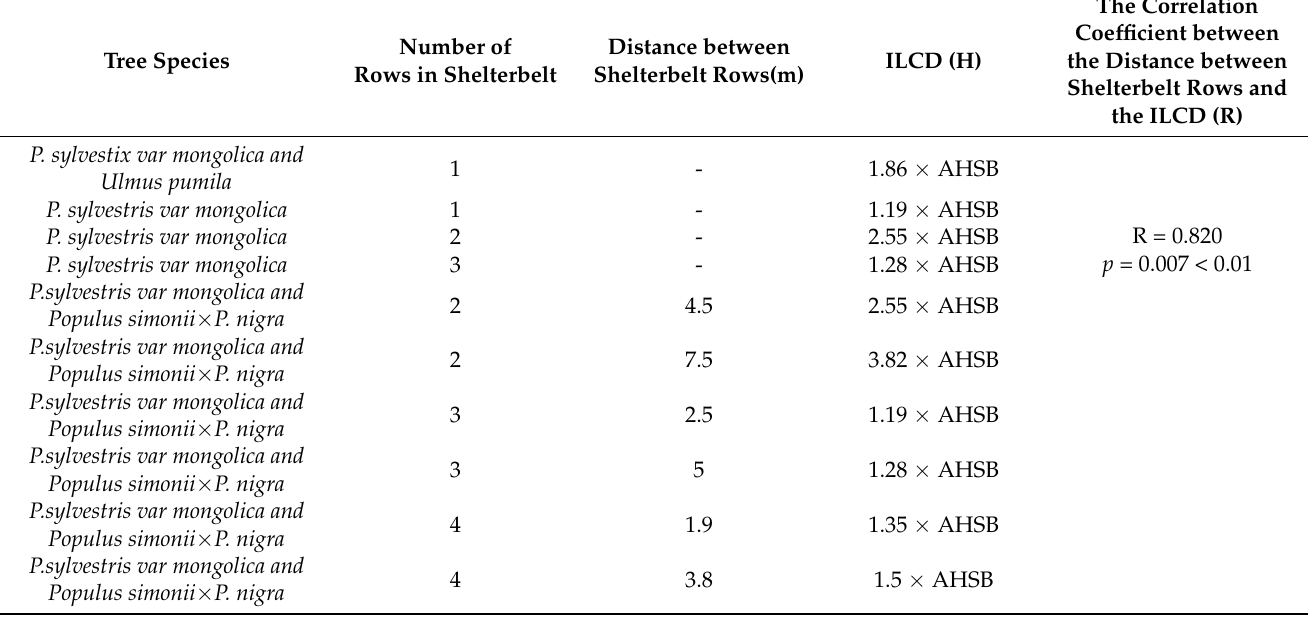
Table 1. The relationship between initial lodging distance (ILCD) for crops on the leeward side of the shelterbelts with different